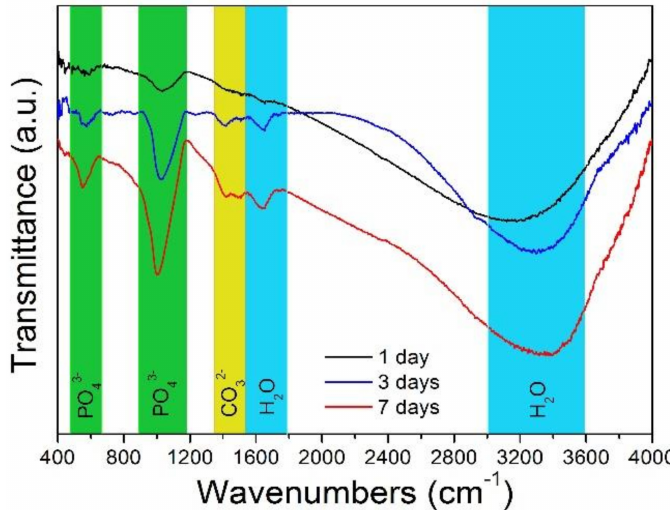
Figure 11. Superficial FTIR (Fourier Transform Infrared spectroscopy) of the extruded Alloy 3 immersed in SBF at 310 K for 1, 3, and 7 days,